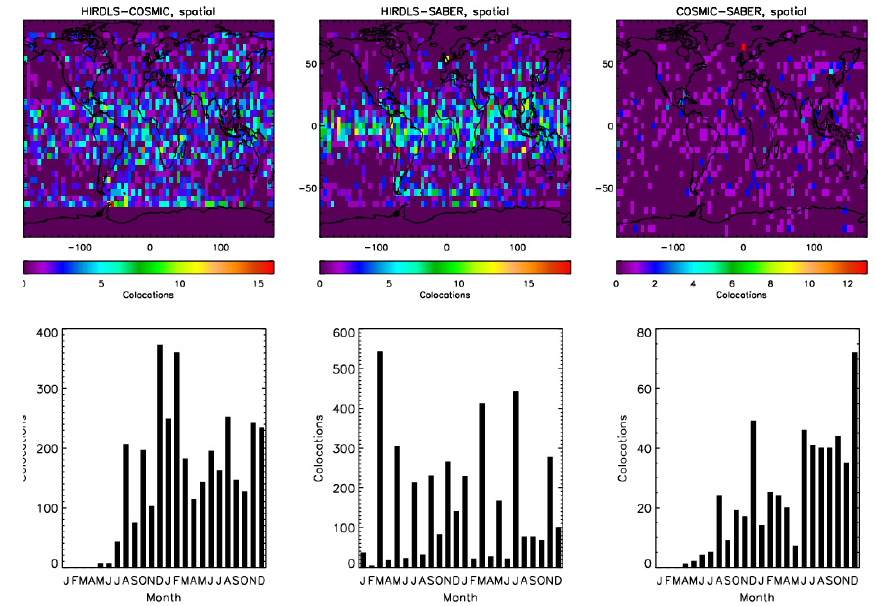
Fig. 6. Details of the temporal and spatial distributions of profile-pairs between each pair of instruments (from left: HIRDLS-COSMIC, HIRDLS-SABER, COSMIC-SABER) after removing low-standard deviation